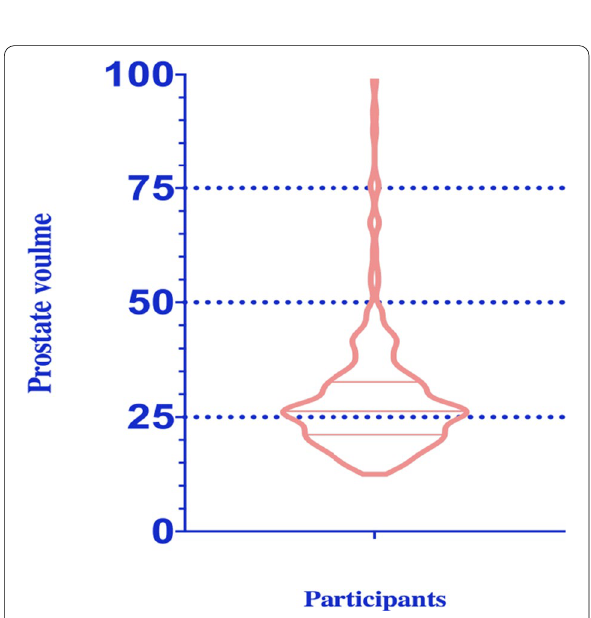
Fig. 2 A violin plot demonstrating the distribution of prostate volume among the participants